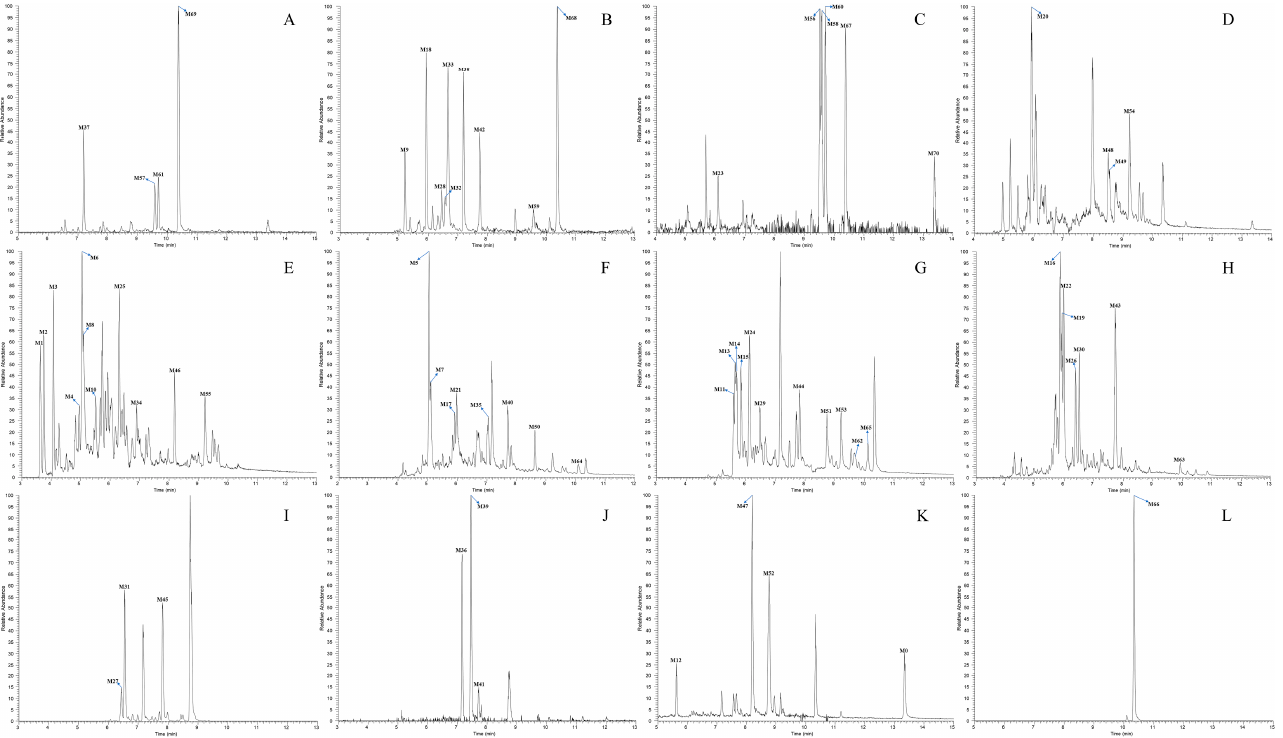
Figure 5. High-resolution extracted ion chromatograms of all DL metabolites in rat plasma, urine, and feces (( A – C ) for plasma, ( D – I ) for urine and ( J – L ) for feces): ( A ) m/z 231.13796, 410.16322; ( B ) m/z 187.14816, 229.12226, 386.16319, 428.17379, 554.21676; ( C ) 213.12746, 245.11716, 390.13692; ( D ) 352.15772, 368.15262, 410.16322; ( L ) 394.16832.